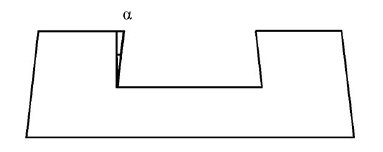
Figure 17. Crooked angle ( α ).